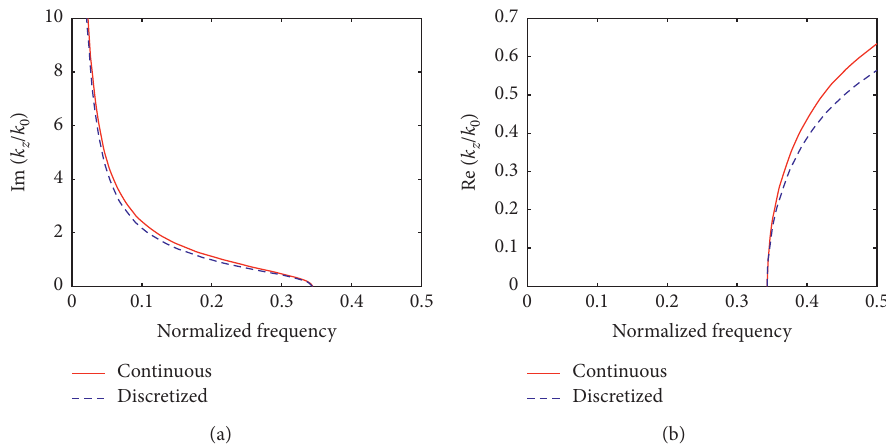
Figure 4: Imaginary part (a) and real part (b) of k wavenumber point ( k x ,k y ) � (40,